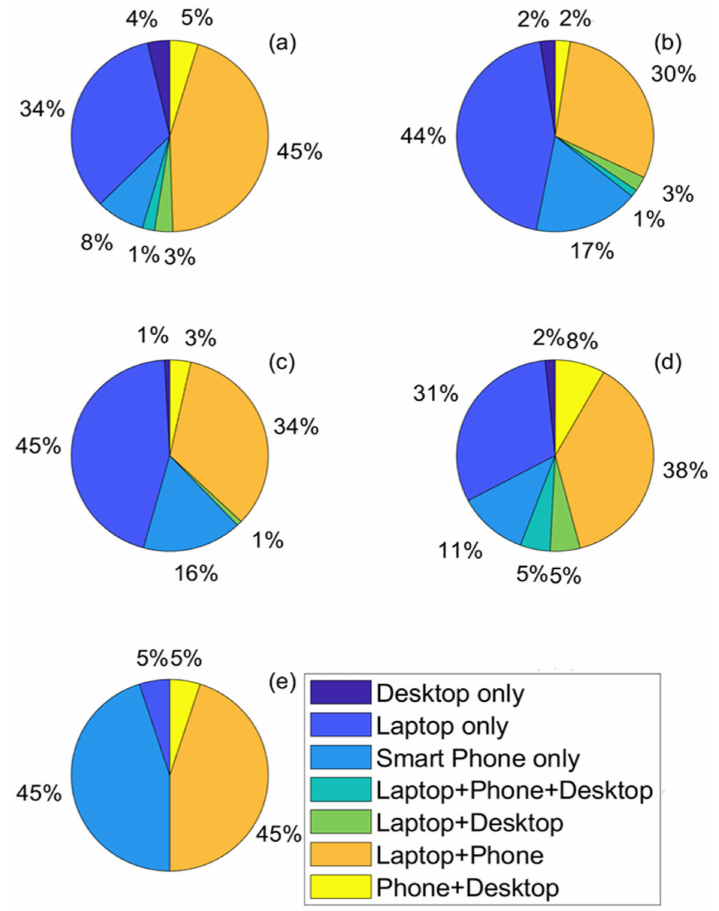
Figure 2. Device combinations used by students in Schools: ( a ) Engineering, ( b ) Technology, ( c ) Busi- ness ( d ), IT and ( e ) Music. Note: percentage shown in each figure is rounded to nearest whole number and hence the total may or may not be equal to